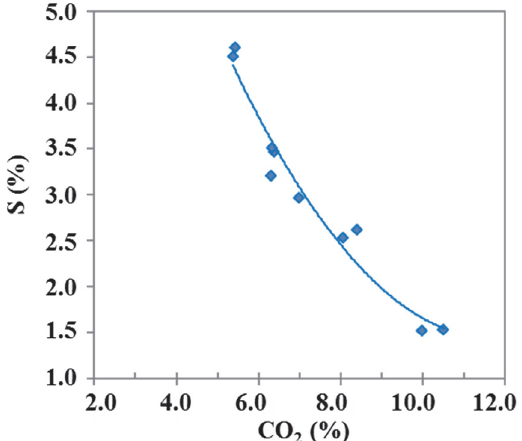
Figure 6 . Interaction between sulfur and carbon dioxide in the Ba- sic Nickel Carbonate , distillation mini-column (Stage